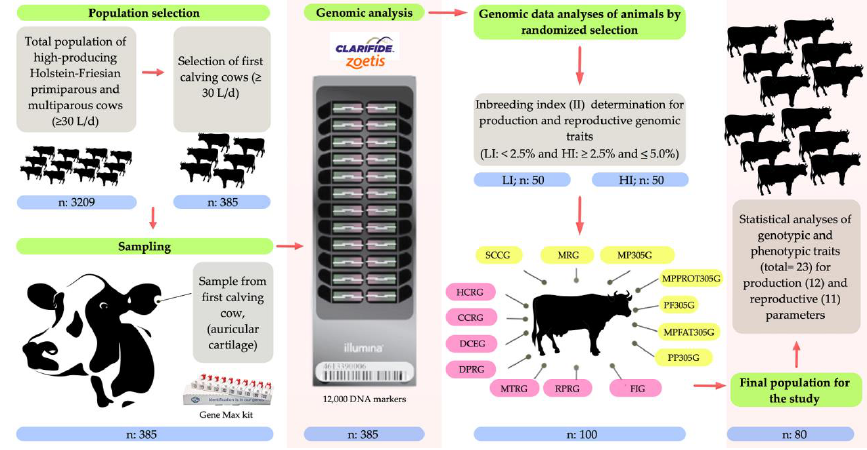
Figure 1. Experimental design map. Dairy cows used for the Inbreeding Index (II) determination (ranges <2.5% and ≥2.5% to ≤5.0) from the total population analyzed ( n = 385) by genomic tests (genotypic and phenotypic parameters). For genomic analysis, the sampling was carried out by using the Gene Max kit (TSU, ALLFLEX, Kalamazoo, MI, USA) and next a chip with 12,000 DNA markers (12K; Illumina Bovine SNP50 BeadChip, Clarifide–Zoetis, San Diego, CA, USA) was used for genotyping. The results have a ~70% reliability based on a panel of 50,000 (HD50K) genetic markers from the Animal Improvement Programs Laboratory (AIPL) (Zoetis–Clarifide, SanDiego, CA, USA). Genomic production values: MP305G: Milk Production at 305 days; MPFAT305G: Fat Production at